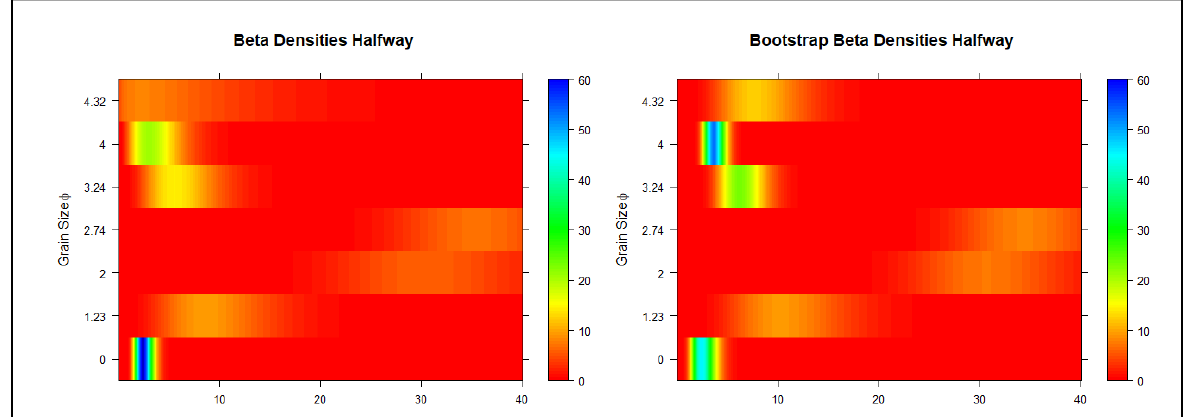
Figure 8. Halfway test—heat maps of original samples and bootstrap samples.